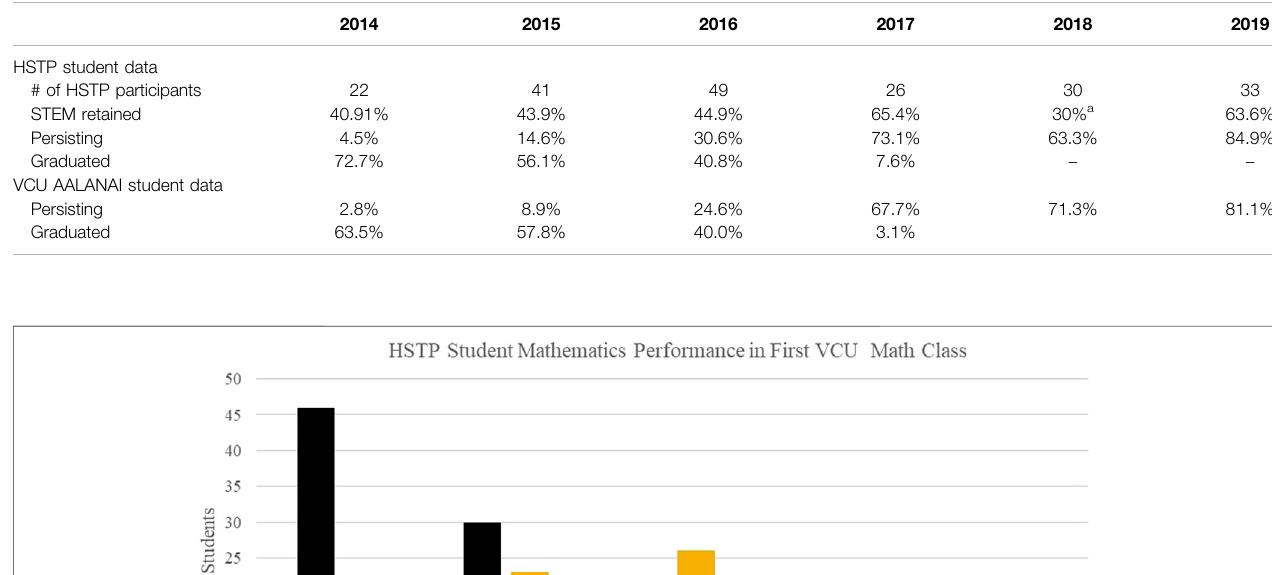
TABLE 5 | Retention and graduation data for HSTP students compared to all AALANAI VCU students.